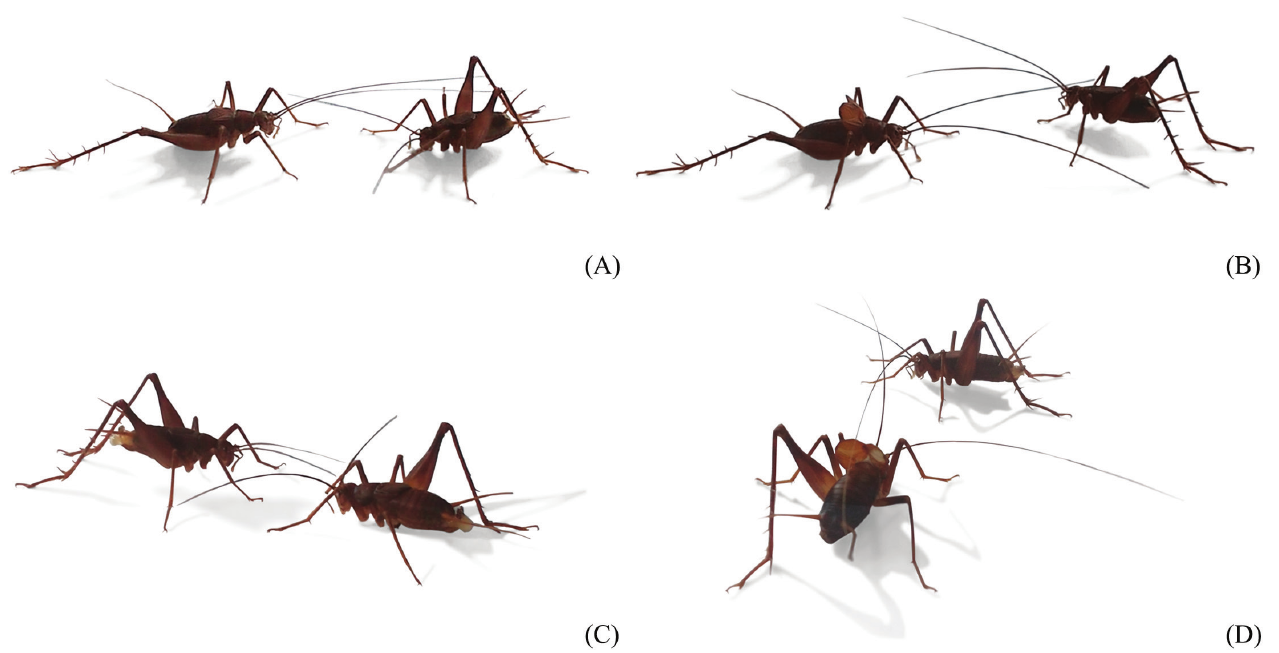
Fig. 1. Male-male interactions of Endecous chape . A . Antennation in face-to-face position; B . One male stridulating while the other lifts up his body; C . Same-sex sexual behavior, with both males producing a spermatophore; D . Male in the center of arena lifting up his body and stridulating, while the other moves to the